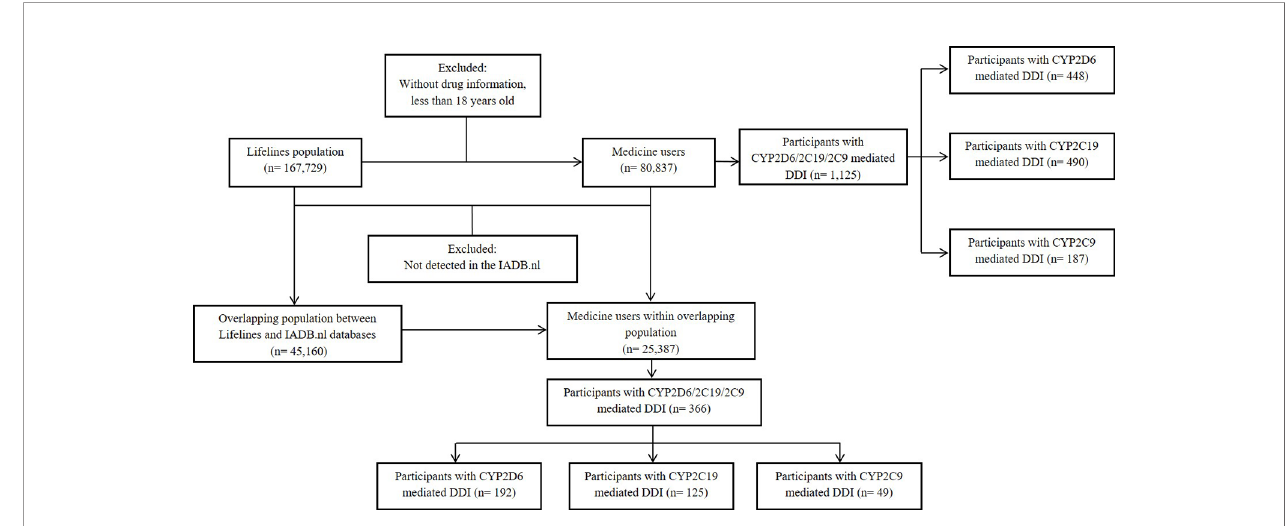
FIGURE 1 | Selection of the population study. DDI, drug-drug interaction.